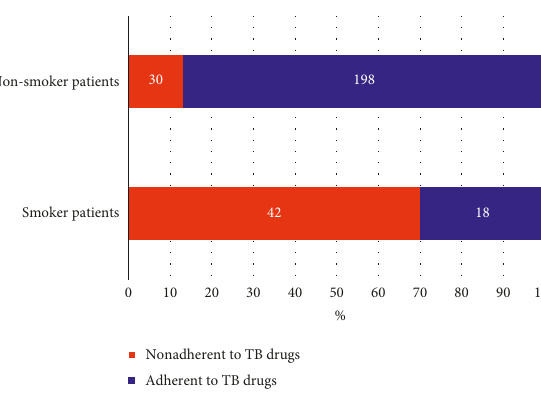
3: The proportion of TB patients who underwent smoking